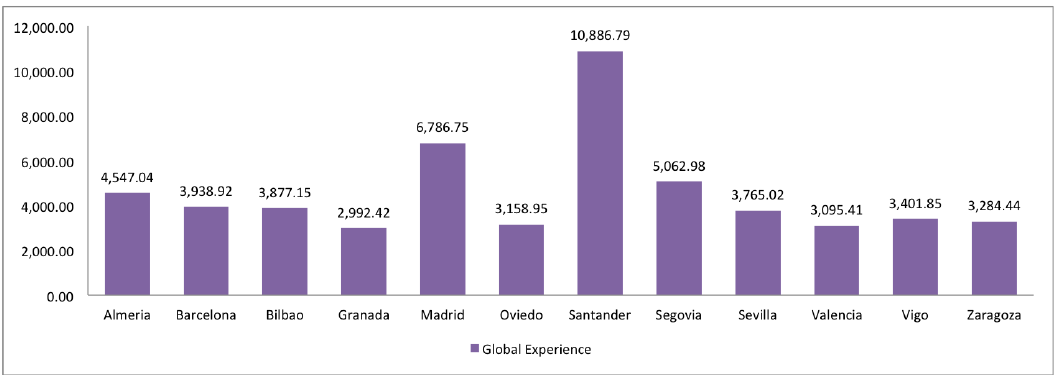
Figure 15. Trust study in Spain: global experience. Average number of contributions in the planet by